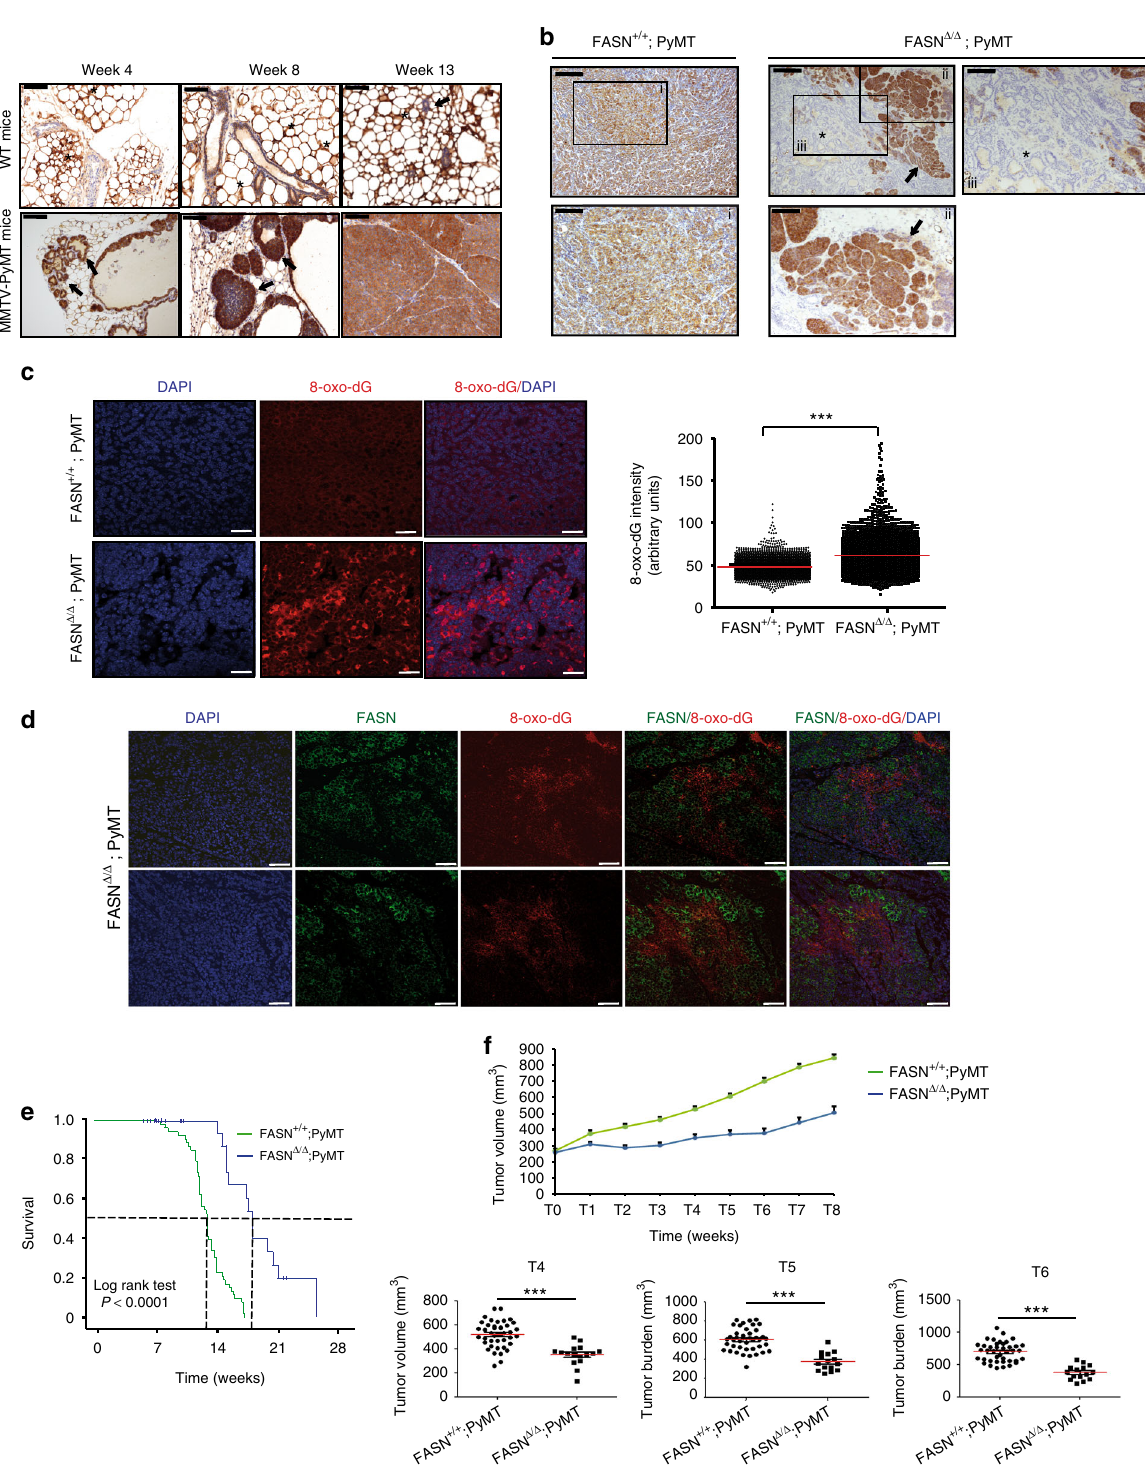
Cell lines ’ generation and treatments . MEFs were isolated from FASN lox/lox embryos (embryos were collected at E12.5). MEFs were grown in Dulbecco ’ s minimum essential media (DMEM, Invitrogen) supplemented with 10% FBS (Sigma) and antibiotics (Sigma) in a humidi fi ed incubator at 37 °C with 5% CO 2 . For immortalization, cultures were retrovirally transduced with SV40 T antigen (in vectors pBABE-hygromycin kindly provided by Manuel Serrano, Spanish National Cancer Research Centre, Madrid). For genetic deletion of FASN, FASN lox/lox MEFs were infected with adeno-Cre (Gene Transfer Vector Core, University of Iowa). Empty adenoviruses (Gene Transfer Vector Core, University of Iowa) were used as a control. MEFs were incubated for 24 h at 37°C with a reduced volume of culture medium containing the virus at the appropriate concentration, and then refed with